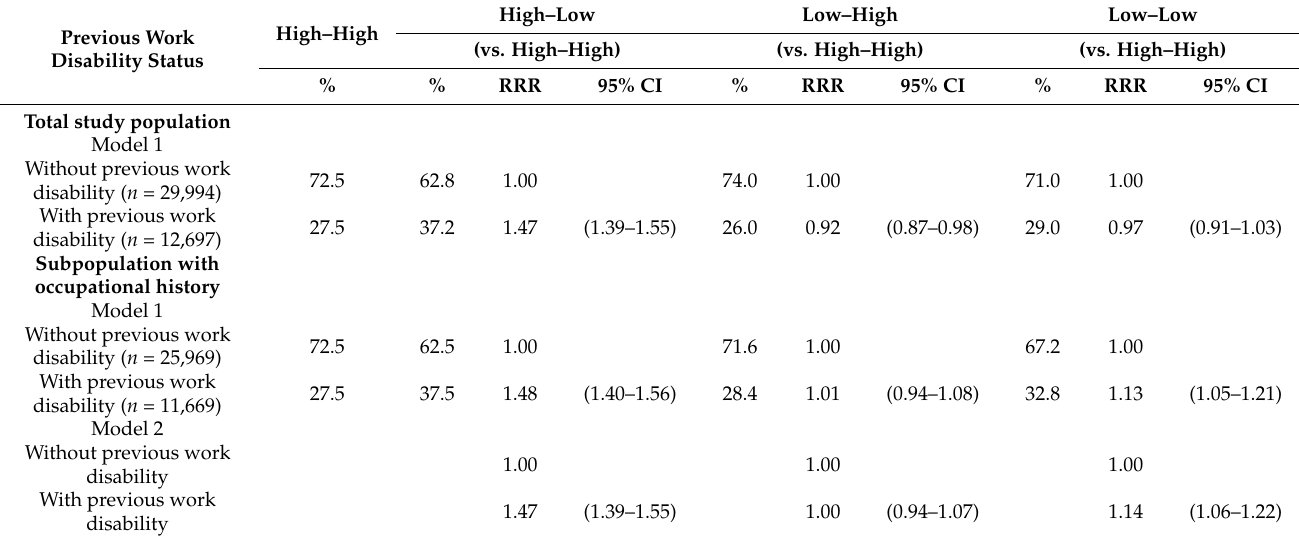
Table 2. Percentage distributions within the trajectory groups of work participation in the open labour market before and after vocational labour market training and relative risk ratios (RRR) and 95% confidence intervals (CI) for being assigned to the trajectory groups by previous work disability